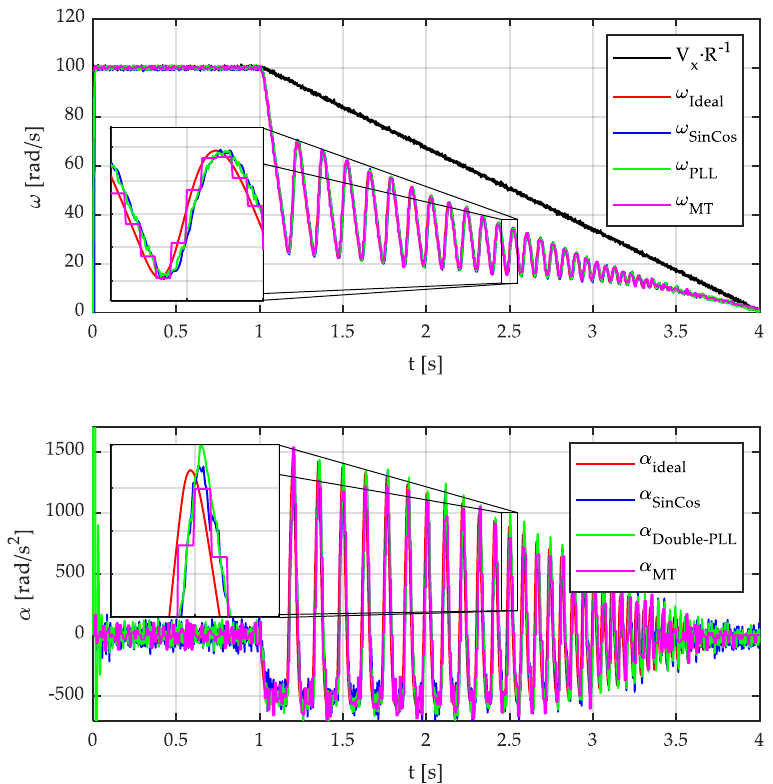
Figure 10. Simulated angular acceleration with noise. Sin-Cos amplitude: 4.5 V. Sin-Cos standard deviation noise: 6 mV.